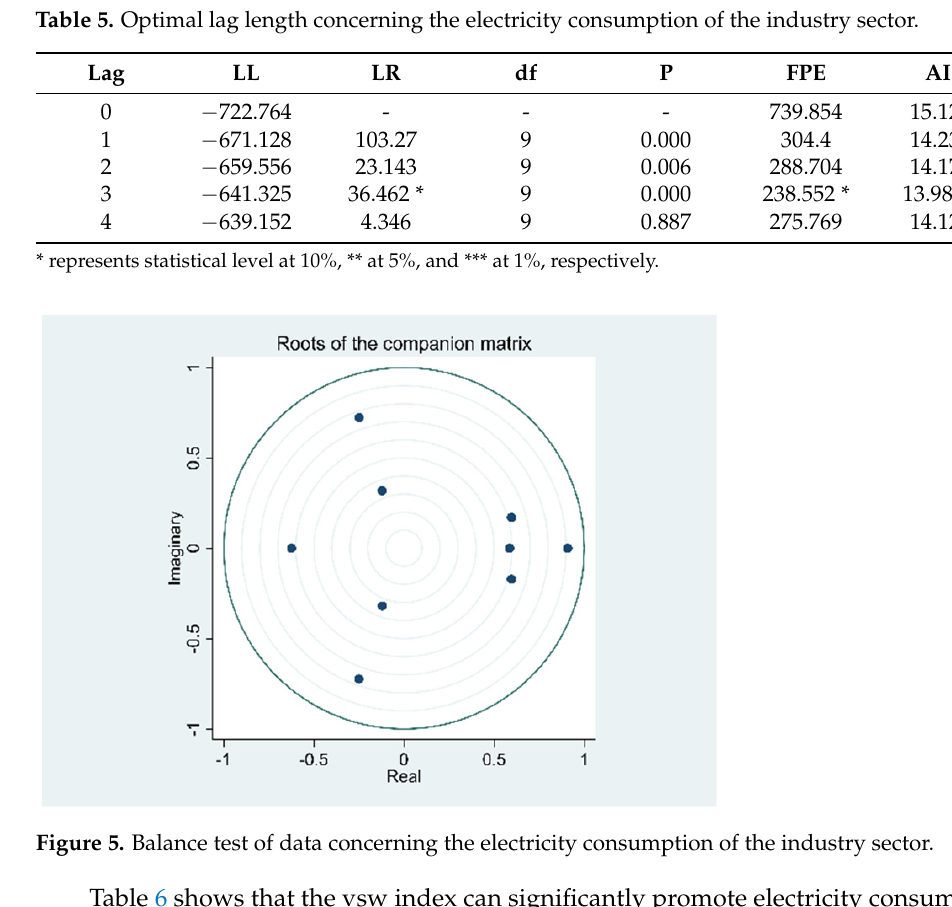
Table 5. Optimal lag length concerning the electricity consumption of the industry sector .